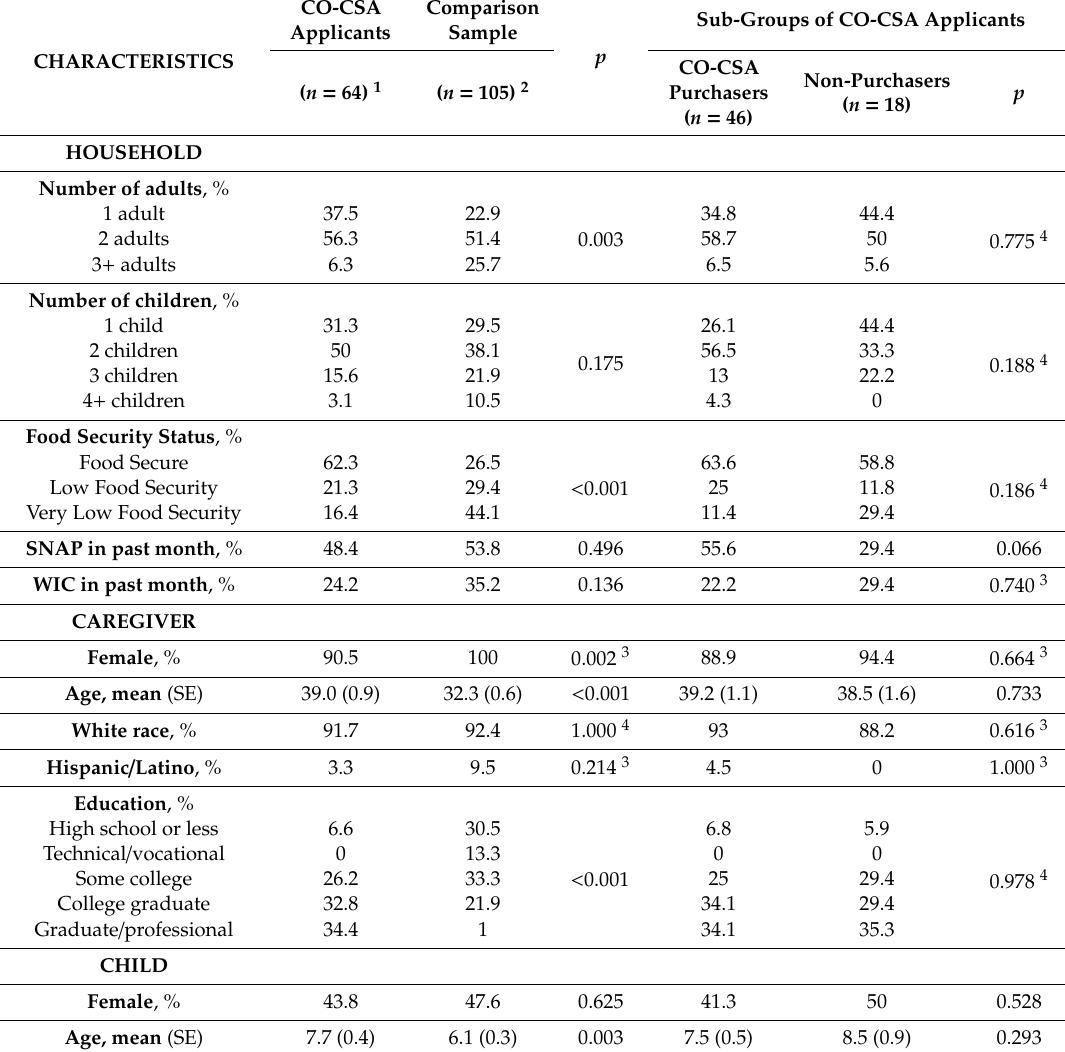
Table 1. Characteristics of low-income applicants to a CO-CSA program ( n = 64) and a comparison sample ( n =